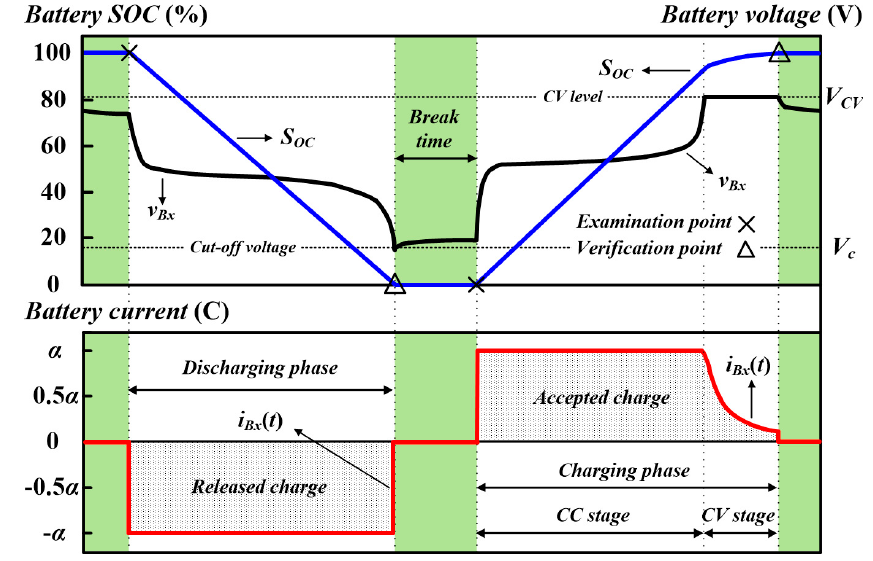
Figure 2. Regular calibration procedure.